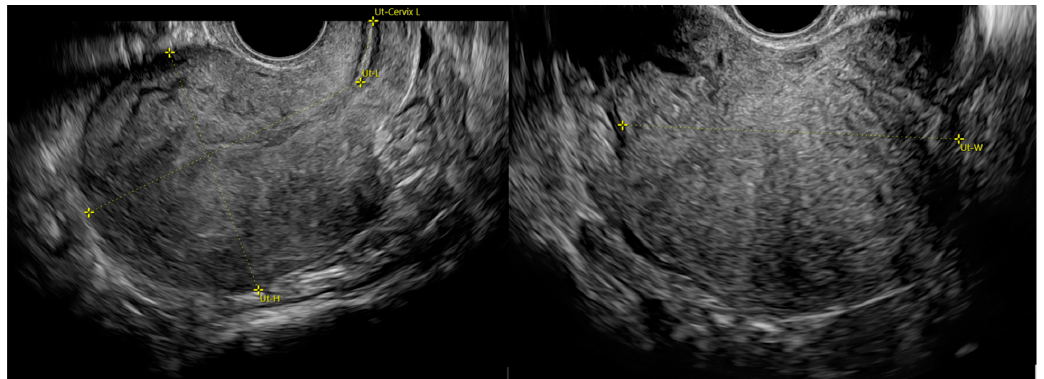
Figure 1. Standardized uterine measurement according to the MUSA consensus [2]. Longitudinal diameter (LD) is the entire uterine length measured as the sum of uterine corpus (Ut-L) and cervix length (Ut-Cervix L). Anteroposterior diameter (APD) and transverse diameter (TD) are measured in the sagittal (Ut-H) and transverse plane (Ut-W),